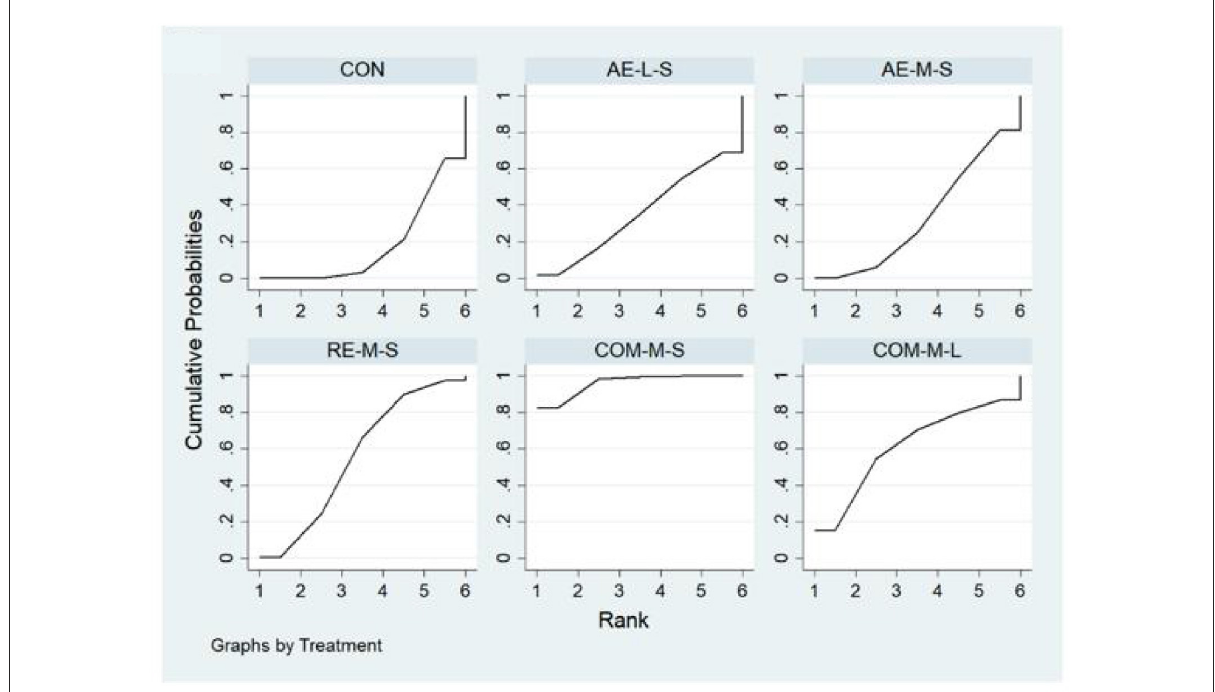
FIGURE5 The surface under the cumulative ranking curve (SUCRA) ranking chart for TPC.